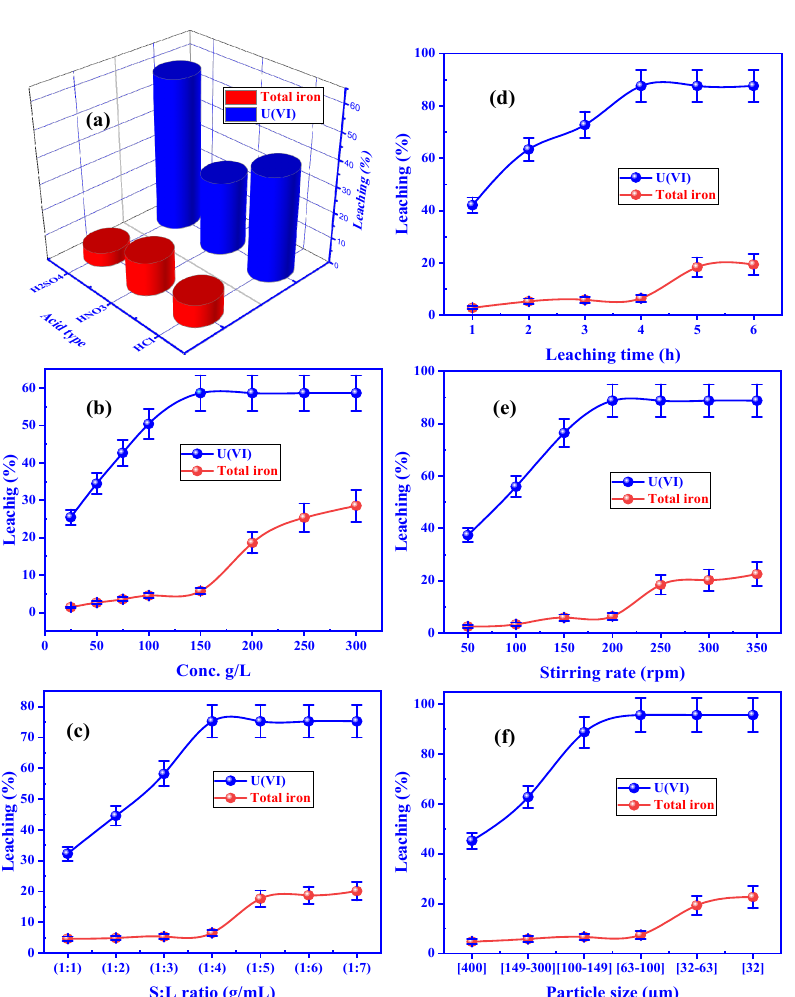
Figure 5. Influence of ( a ) leaching types, ( b ) sulfuric acid concentration, ( c ) solid-to-liquid ratio, ( d ) leaching time, ( e ) stirring speed, and ( f ) particle size on leaching efficiency of U(VI) and total iron from El Sela mineralization.